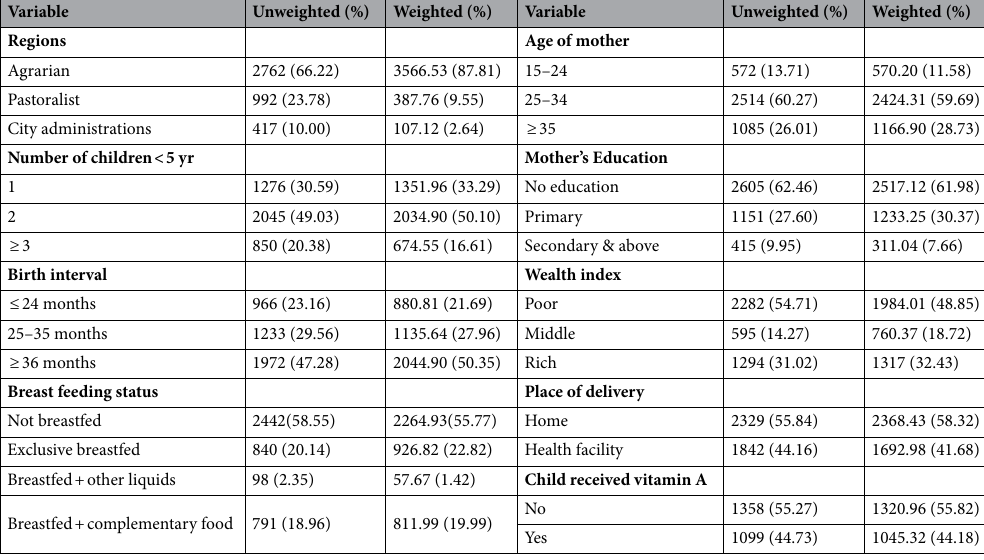
Table 2. Factors associated with timely initiation of complementary feeding in Ethiopia, EMDHS 2019.